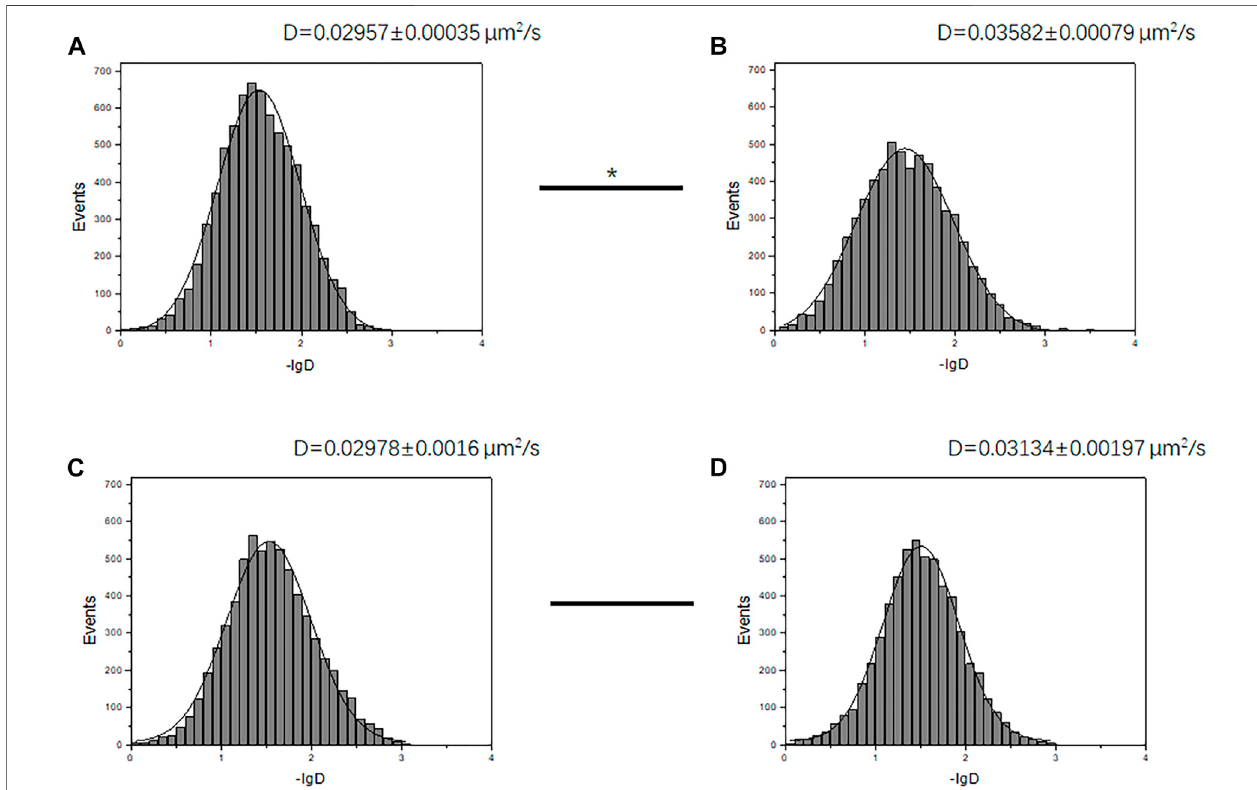
FIGURE6| Receptordiffusionrate changed before and after receptor stimulationunder different conditions. (A, B) Diffusionrates Dofmembrane-docked GBR1- EGFP/GBR2moleculesinHEK293cellswiththemarkedDvaluebefore (A) andafter (B) GABAstimulation,atalowGABABRexpressionlevel(transfectiontime6 h).The two groups of D values were signi fi cantly different ( p < 0.05, Mann – Whitney U test). (C, D) Diffusion rates D of GBR1-EGFP/GBR2 molecules before (C) and after (D) GABA stimulation, at a high GABABR expression level (transfection time 12 h). The two groups of D values did not have signi fi cant difference. The ligand concentration used in stimulation is 1